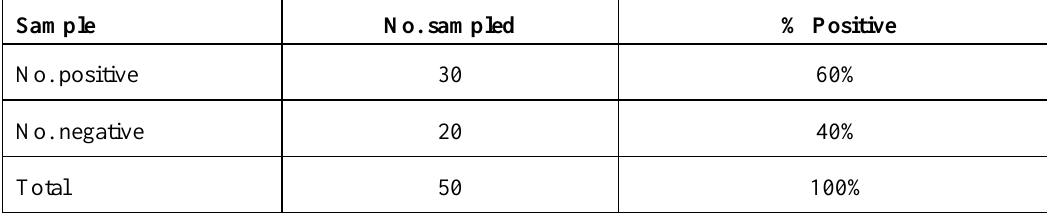
Table 1. Frequency of positive C. albicans among pregnant women.